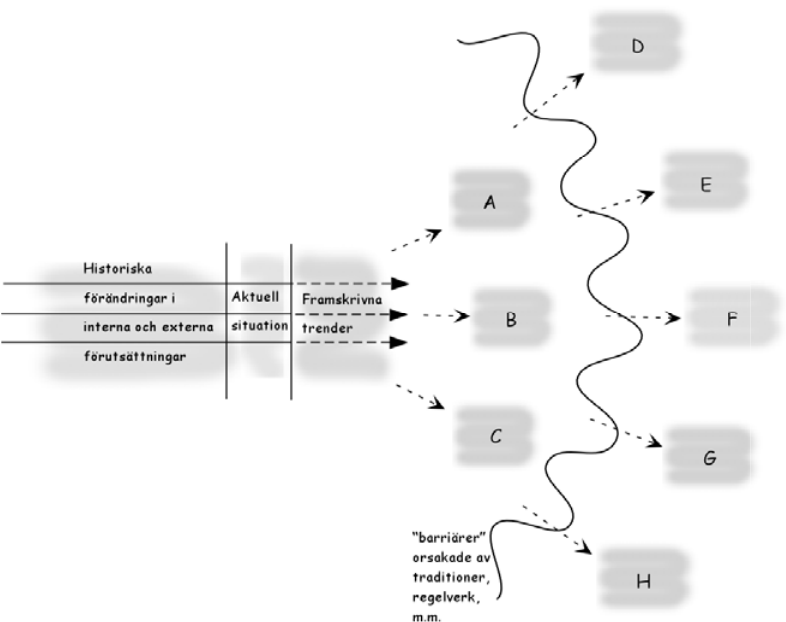
olika scenarier över rennäringens utveckling.